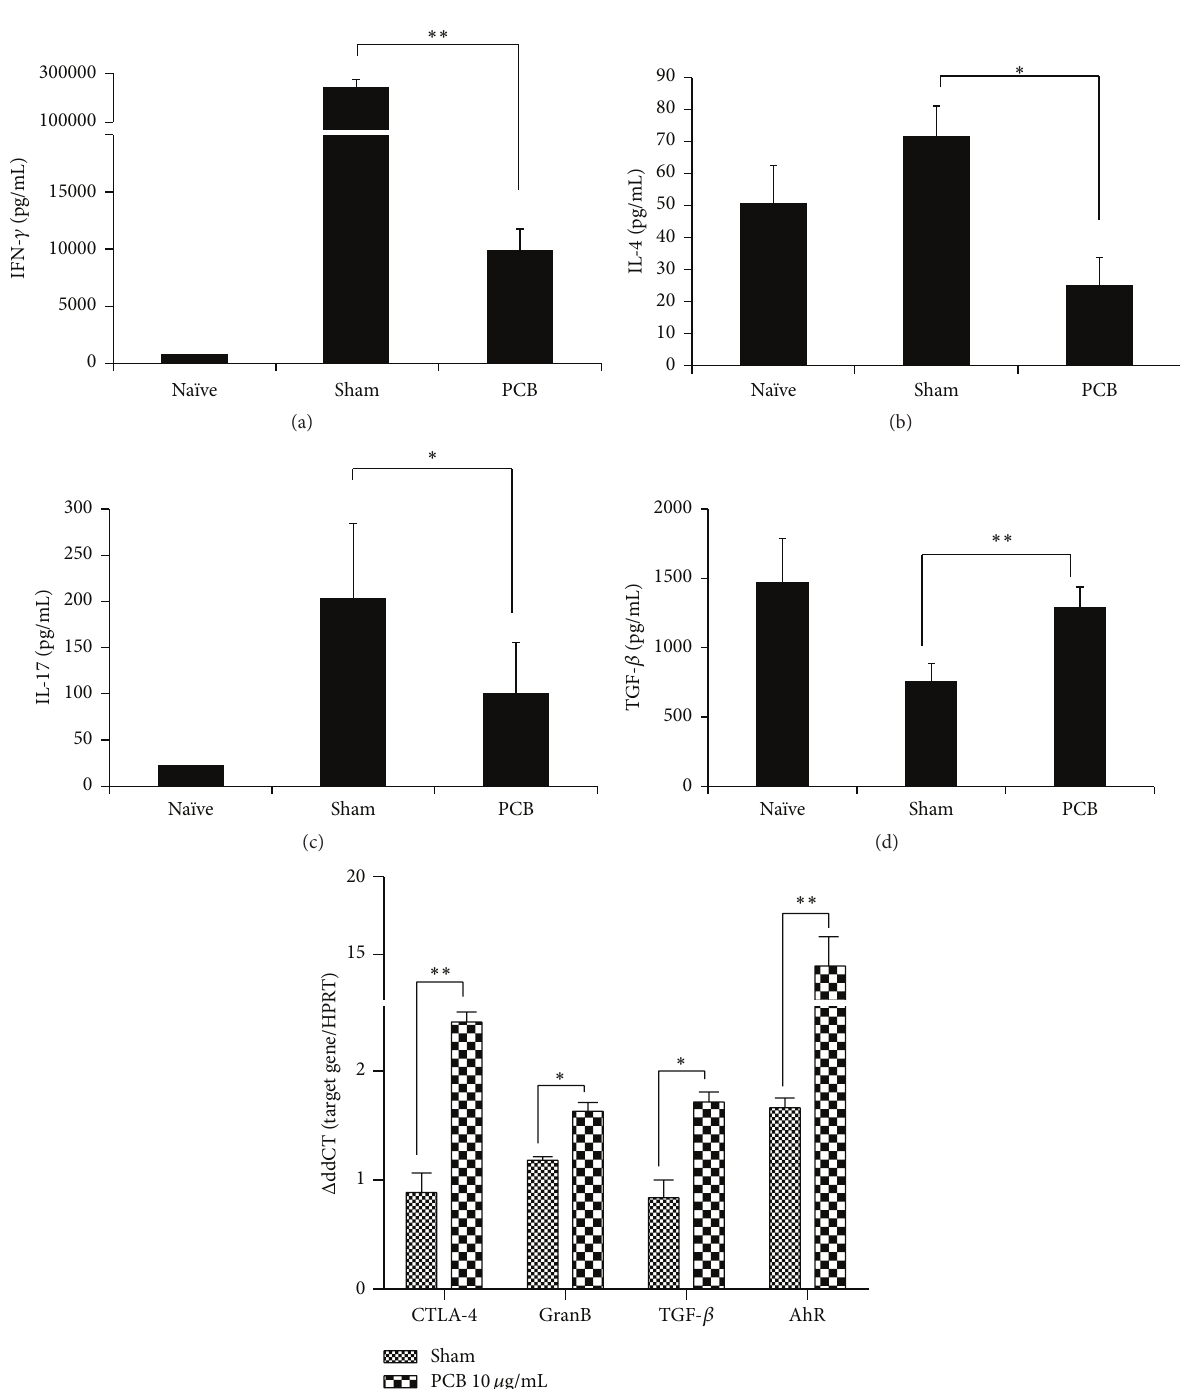
Figure 7: PCB extract contributed to an expanded population of inducible T regulatory cells. CD4 + CD62L + na¨ıve T cells from splenocytes and mLN cells from BALB/c mice were cultured with 10 𝜇 g/mL plate-bound anti-CD3 mAb and 2 𝜇 g/mL soluble anti-CD28 mAb in the presence of 0–10 𝜇 g/mL PCB. After three days, the levels of IFN- 𝛾 (a), IL-4 (b), IL-17 (c), and TGF- 𝛽 (d) in the culture supernatants were measured using ELISA. Data are presented as the mean ± SD of triplicate determinations and were analyzed using ANOVA followed by F - protected Fisher’s least significant difference test. ∗ 𝑃 < 0.05 ; ∗∗ 𝑃 < 0.01 versus OVA control. (e) The expression of Treg-associated molecules was compared between the sham and experimental groups. GranB: Granzyme B. Data are presented as the mean ± standard deviation (SD) of triplicate determinations and were analyzed using unpaired 𝑡 -test. ∗ 𝑃 < 0.05 and ∗∗ 𝑃 < 0.01 versus OVA